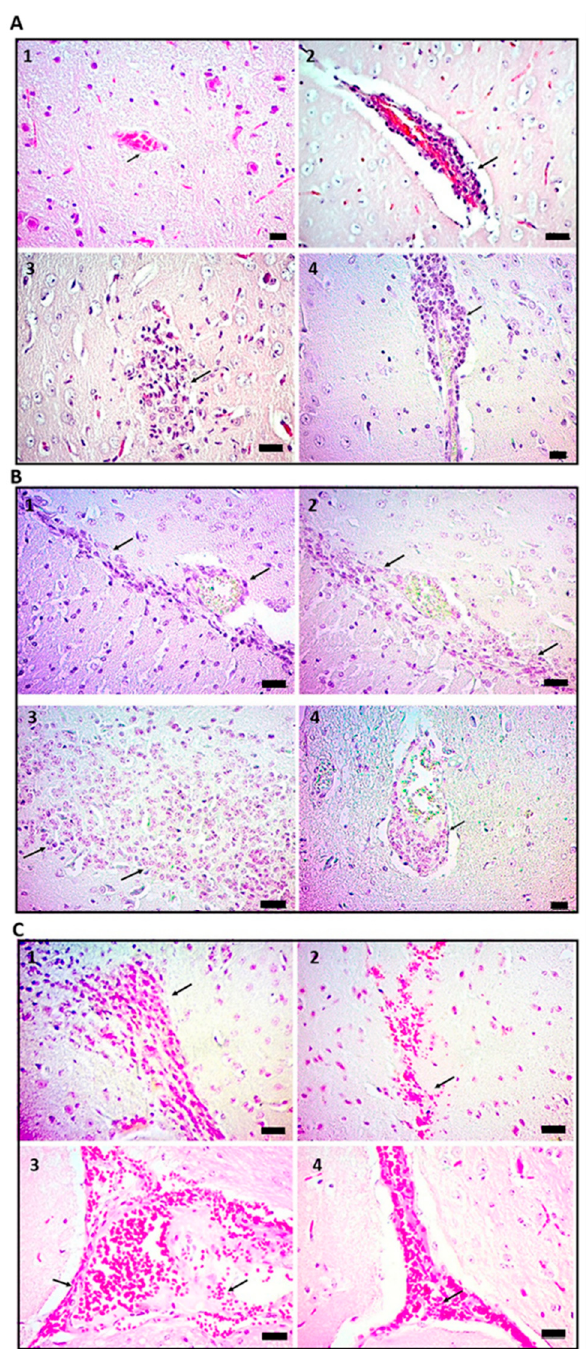
Figure 1. Histopathological features of the brain. ( A1 ) control, the arrow point to normal blood vessel; ( A2 , A3 ) vasculitis with perivascular lymphocytic inflammatory infiltrate and cerebral edema on day 1 after the re-challenge with Mtb antigens; ( A4 ) vasculitis and cerebral edema on day 14 with mononuclear inflammatory infiltrate, arrows in A2-A4 point to lymphocytic inflammatory infiltrate; ( B1 – B3 ) strong induction of vasculitis, cerebral edema, and meningitis with lymphocytic inflammatory infiltrate on day 14; ( B4 ) perivascular lymphocyte infiltration and cerebral edema on day 21, arrows in B1-B4 point to lymphocytic inflammatory infiltrate; ( C1 , C2 ) vasculitis, vascular ectasia, mild cerebral edema, and persistent meningitis on day 28, arrows mark the lymphocytic inflammatory infiltrate and small blood vessel with ectasia; ( C3 , C4 ) focal histopathological changes with vascular ectasia, inflammatory infiltrate, and mild cerebral edema on day 60, arrows point to congested blood vessels. Hematoxylin and eosin stain 40 × . Scale bar 20 µ